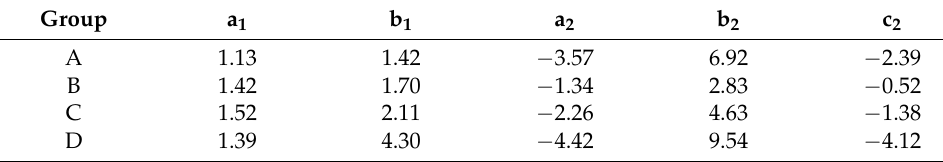
Table 5. Parameters of the regressed diagrams.